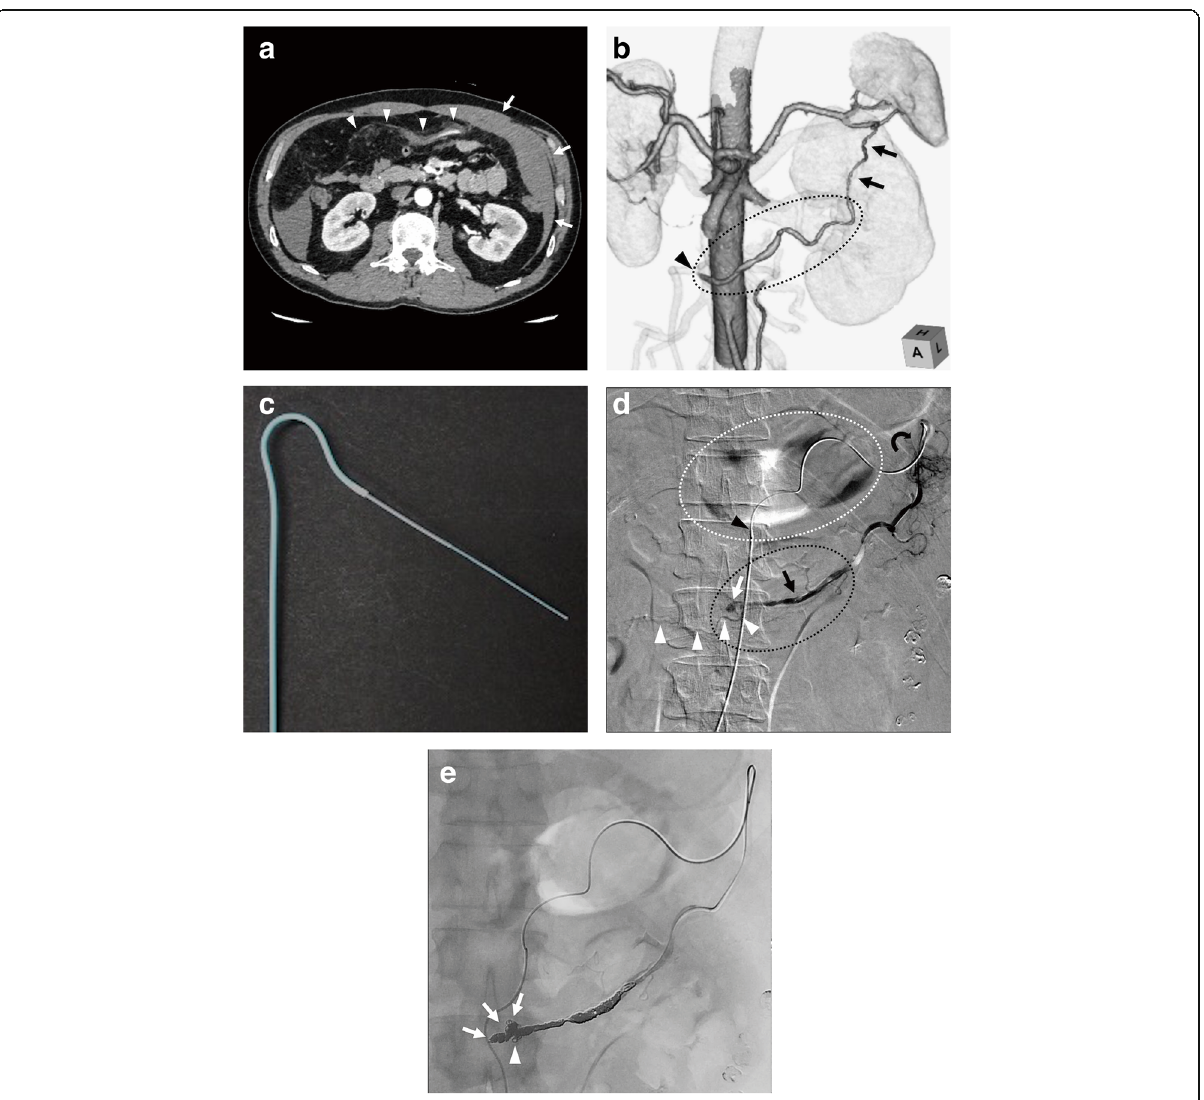
Fig. 1 Images from a 55-year-old man with left omental artery (OA) bleeding associated with segmental arterial mediolysis (SAM). a Axial contrast-enhanced computed tomography (CT) reveals massive intraperitoneal high-density ascites mainly involving the left portion of the greater omentum (arrows) where the OA with the dilated, stenotic change develops the possible hematoma (arrowheads). b Coronal volume- rendered image from CT in the cranial and left anterior oblique projection reveals that the left OA (arrows) arising acutely from a splenic artery branch and coursing away from the greater curvature develops dilated, stenotic change (dotted circle) and that the potential bleeding site at the distal portion of left OA (arrowhead) is far from celiac artery. SAM is the most likely diagnosis, and transarterial embolization is planned. c Photograph of the triaxial catheter system consisting of a 4.2 Fr shepherd ’ s hook catheter, a 2.8 Fr high-flow microcatheter and a 2.0 Fr microcatheter, which serves as the outermost, intermediate, and innermost catheters, respectively. d Digital subtraction angiography (DSA) of the left OA in posteroanterior projection using the triaxial catheter reveals a pseudoaneurysm in the distal portion (white arrow). Note an intact distal left. OA runs through (white arrowheads). Coil embolization is planned to isolate the proximal and distal artery (black dotted circle). Note that the SAM-associated left OA courses away from the greater curvature (white dotted circle), which means that this artery differs from left gastroepiploic artery. Note each tip of the triaxial catheter system consisting of the 4.2 Fr shepherd ’ s hook catheter (black arrowhead), the 2.8 Fr high-flow microcatheter (black curved arrowhead) and the 2.0 Fr microcatheter (black arrow). e DSA of the left OA in posteroanterior projection after embolization reveals complete hemostasis. Note that distal omental artery including the pseudoaneurysm (arrows) is densely embolized and that the distal normal left OA is also embolized with metallic coils